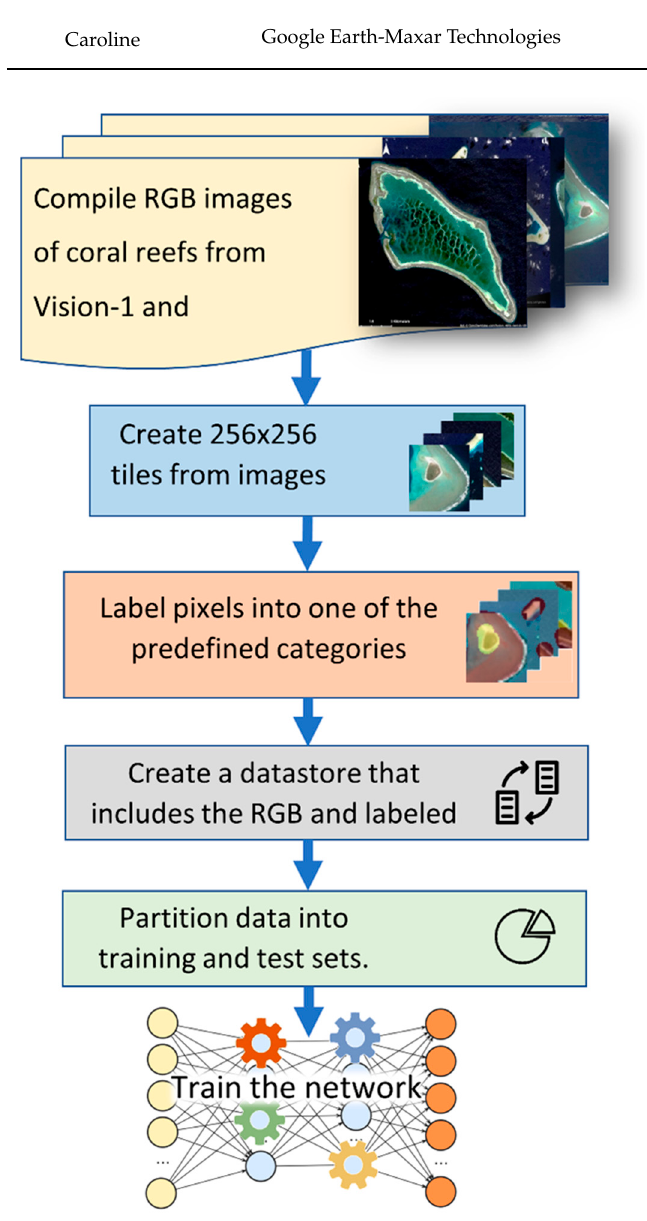
Figure 3. Flowchart showing the general steps followed for compiling and preparing data to train deep-learning network to identify black reefs.